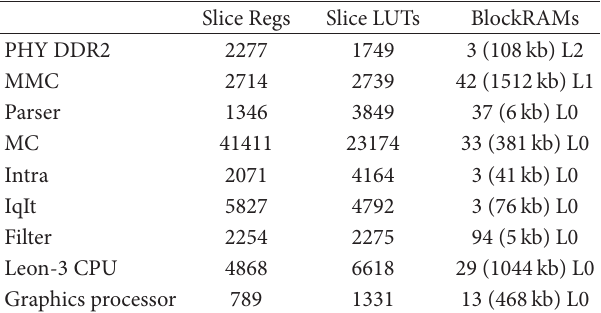
T 1: Synthesis results for Xilinx XC5VLX110T